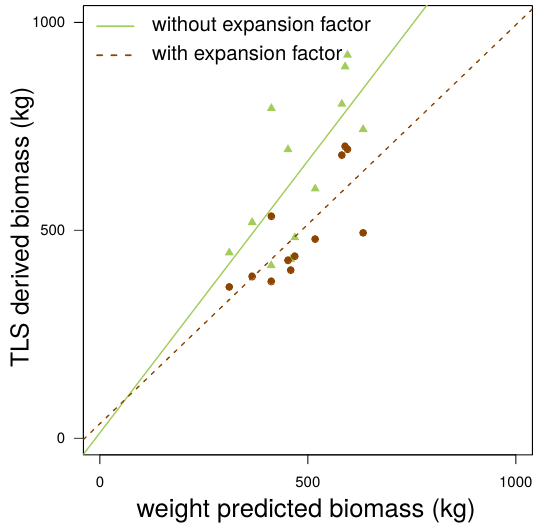
Figure 7. Two linear models utilizing both biomass weight of 12 Q. petraea as independent and either the biomass TLS ( f( x ) = 1.31 x + 13.24, adj. r 2 = 0.46 ) or biomass TLS ∗ ( f( x ) = 0.96 x + 35.03, adj. r 2 = 0.54 ) as dependent